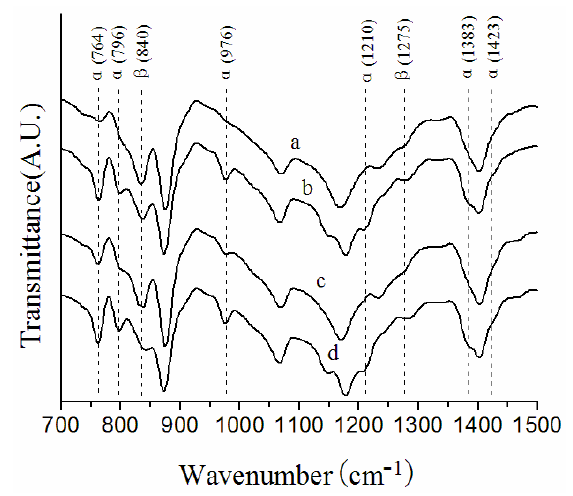
Figure 2. FTIR-ATR spectra of solution-cast membranes prepared at different conditions. ( a ) F5-60; ( b ) F5-140; ( c ) F5-7-60; ( d )